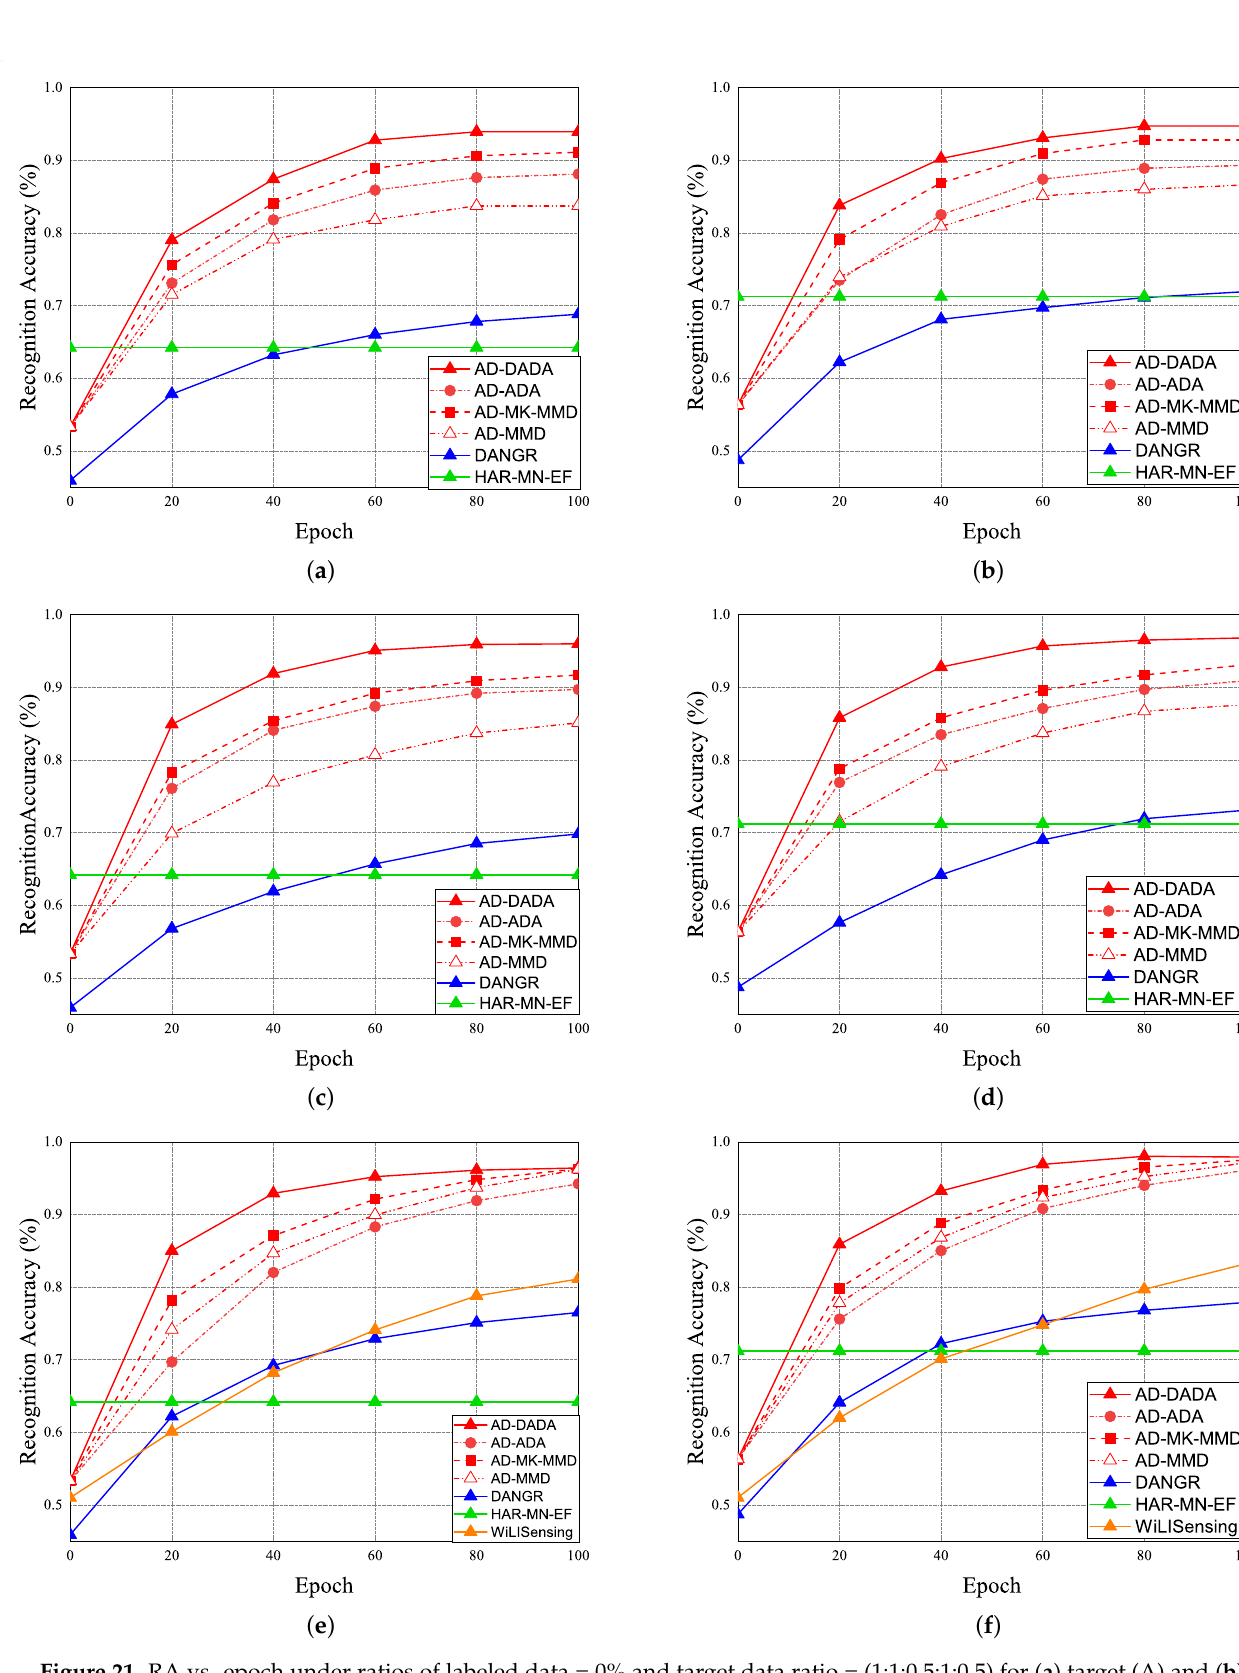
Figure 21. RA vs. epoch under ratios of labeled data = 0% and target data ratio = (1:1:0.5:1:0.5) for ( a ) target (A) and ( b ) target (B). RA vs. epoch under ratios of labeled data = 25% and target data ratio = (1:1:0.5:1:0.5) for ( c ) target (A) and ( d ) target (B). RA vs. epoch under ratios of labeled data = 100% and target data ratio = (1:1:0.5:1:0.5) for ( e ) target (A) and ( f ) target